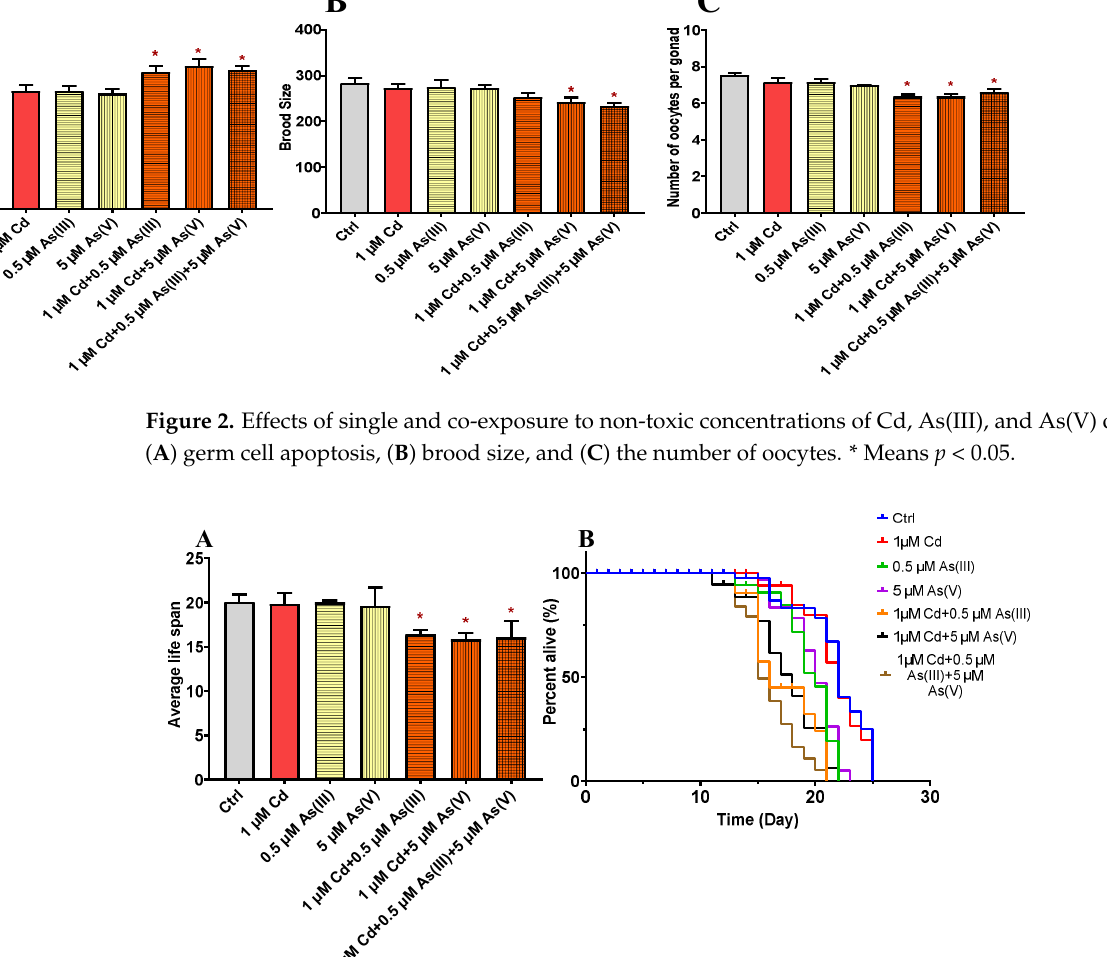
Figure 1. Images of AO stained apoptotic cells in the gonads ( A , B ) and the determination of non-toxic concentrations of ( C ) Cd, ( D ) As(III), and ( E ) As(V) based on germ cell apoptosis. * means p < 0.05.